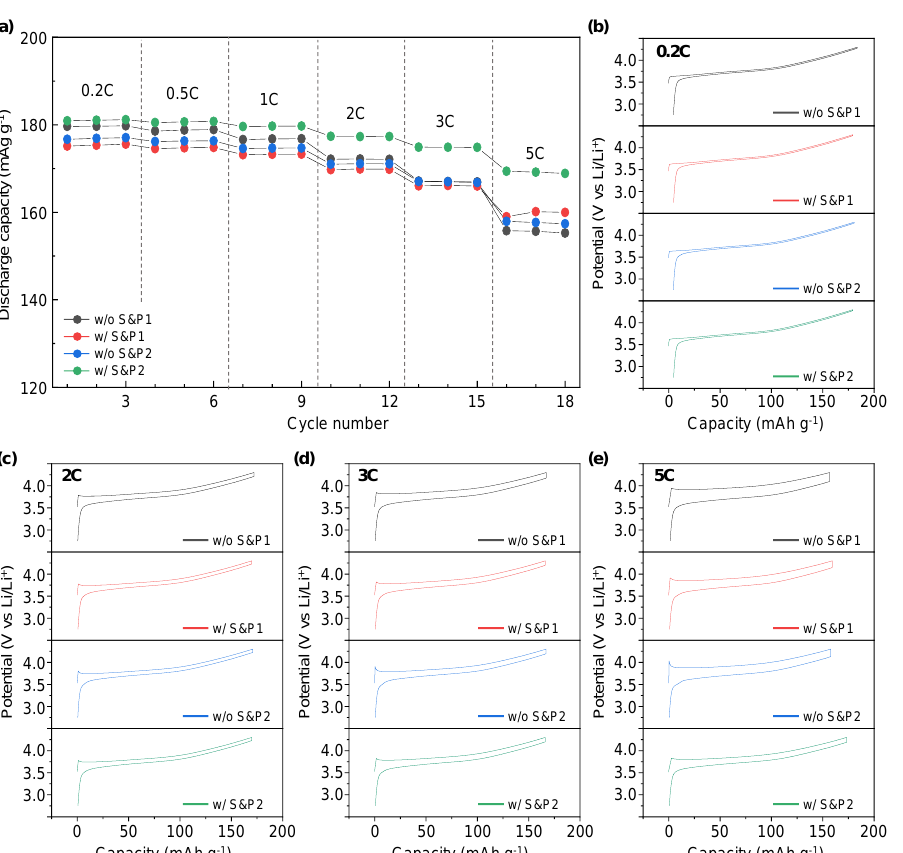
Figure 4. ( a ) Rate capability of without S&P1, with S&P1, without S&P2, and with S&P2 at cycle discharge current rates of 0.2C − 5C within the potential range of 2.75–4.5 (V vs. Li/Li + ). Voltage profile of ( b ) 0.2C, ( c ) 2C, ( d ) 3C, and ( e ) 5C showing charge and discharge cycles. The curves come from the rate data in ( a ).